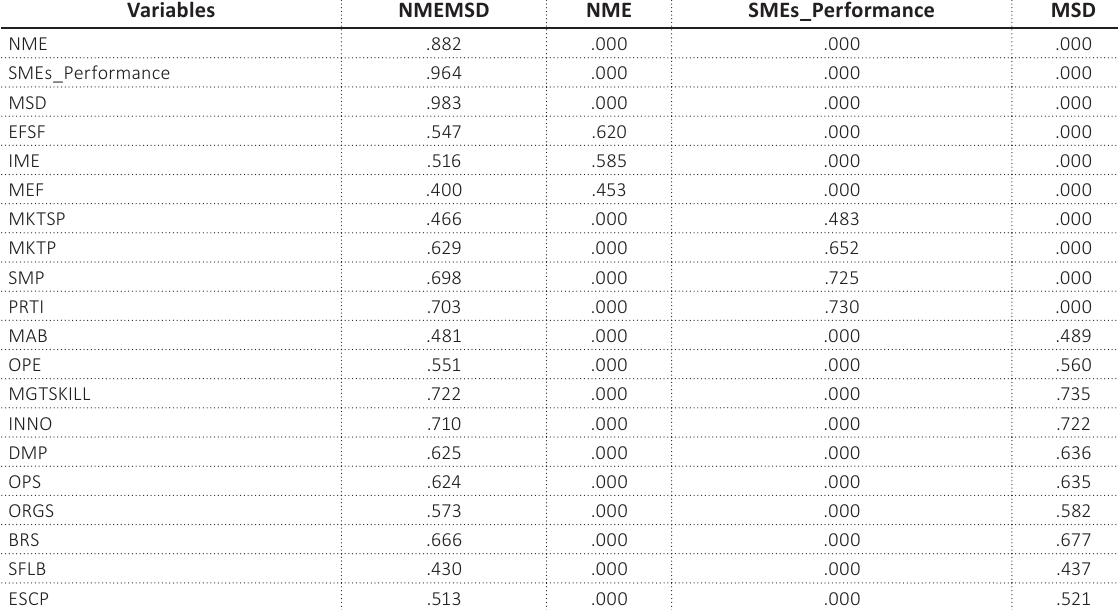
Source: Field survey results